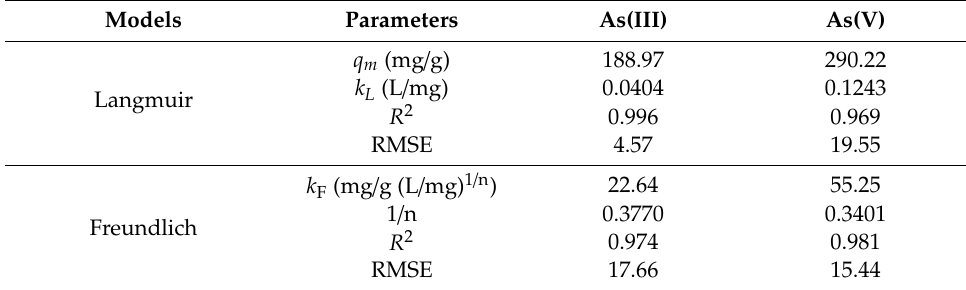
Table 3. Sorption isotherm parameters for As(III) and As(V) using CF-NCs as sorbents.